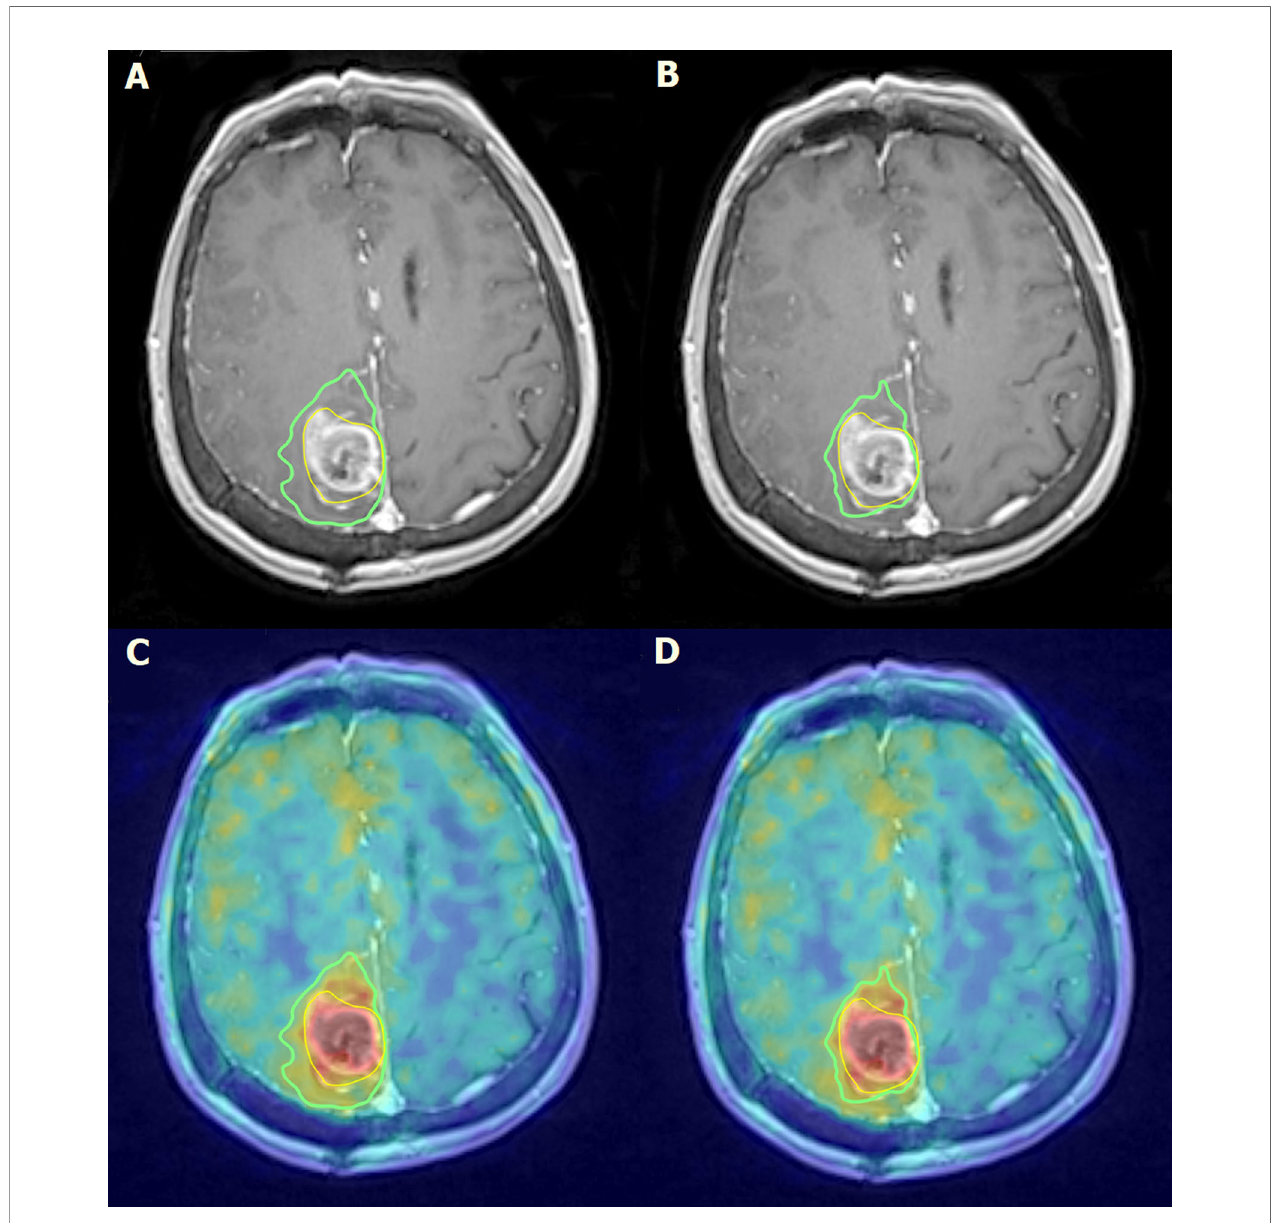
FIGURE 2 | Parieto-medial postoperative status on the right side of the brain. In the surgical region, a fl uid-containing cavity with small air bubbles and uneven contrast enhancement can be detected on post-contrast T1-weighted MRI images (A, B) . Uneven 18F-FDOPA accumulation can be observed at the edges of the deviation on fused 18F-FDOPA PET/MRI images (C, D) . Intense contrast and 18F-FDOPA accumulation suggests of the presence of a residual tumor around the surgical cavity. The yellow line describes the GTV volume (A – D) , the green line on panels (A, C) describes the BTV 1.7 accumulation coverage and the green line on panels (B, D) describes the BTV 2.0 accumulation